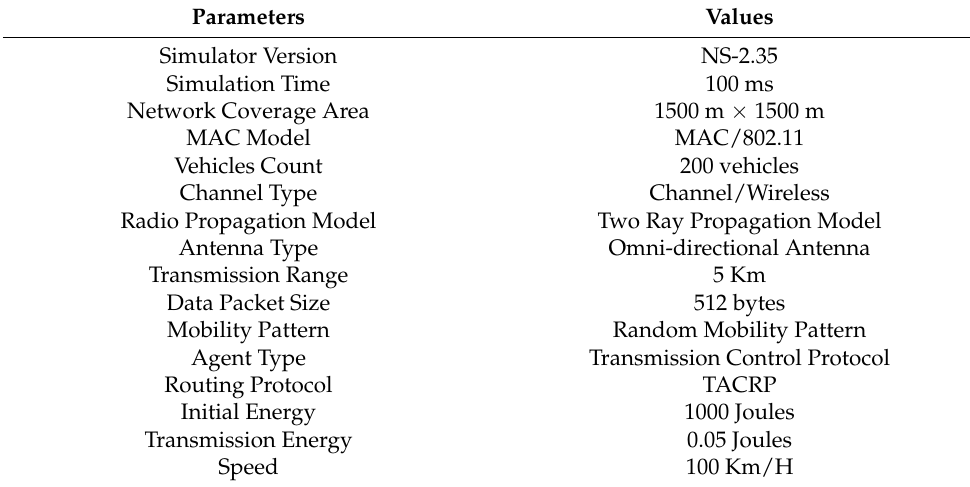
Table 2. Simulation Parameter